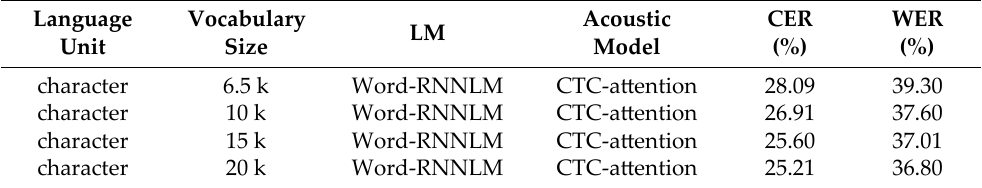
Table 1. Character‑based end‑to‑end model results in different vocabulary sizes.